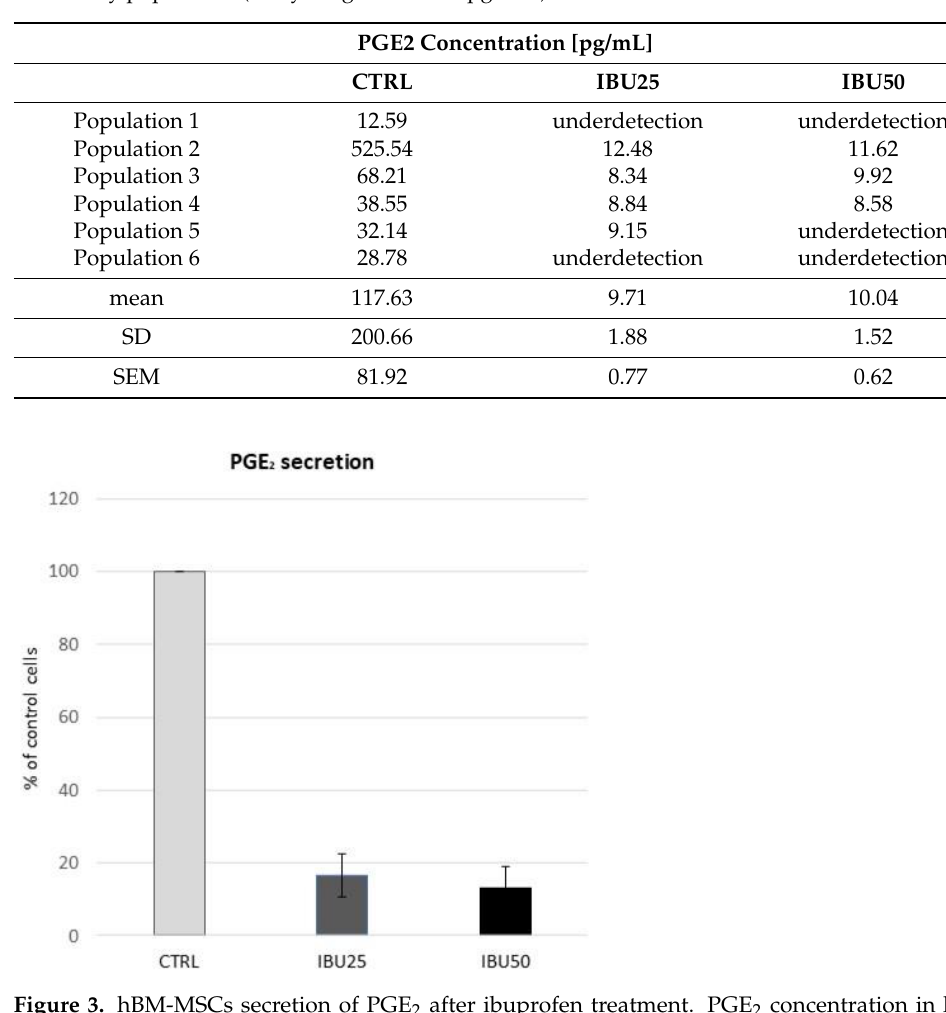
Figure 3. hBM-MSCs secretion of PGE 2 after ibuprofen treatment. PGE 2 concentration in hBM-MSCs supernatants collected from 6 different populations was quantified with ELISA immunoassay after 24 h of incubation with 25 µg/mL or 50 µg/mL ibuprofen. Relative PGE 2 concentration in superna- tants from cells treated with ibuprofen versus control